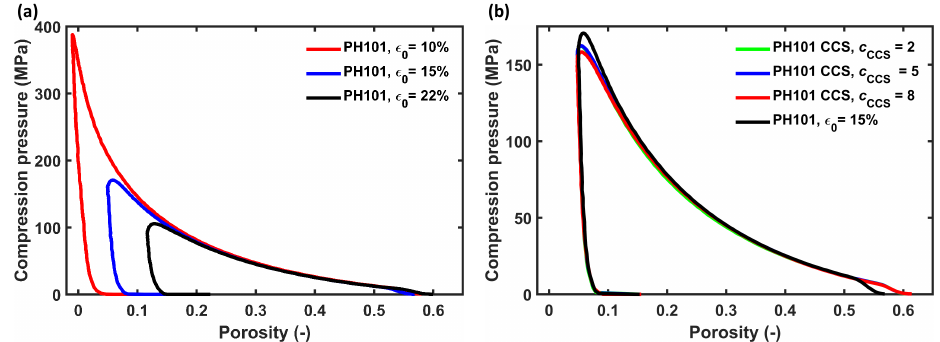
Figure 4. Experimental compression profile of ( a ) MCC PH101 tablet with porosities of 10%, 15%, and 22% and ( b ) MCC PH101 and CCS tablet of c CCS = 2, 5, and 8 compared with MCC PH101 tablet with a porosity of